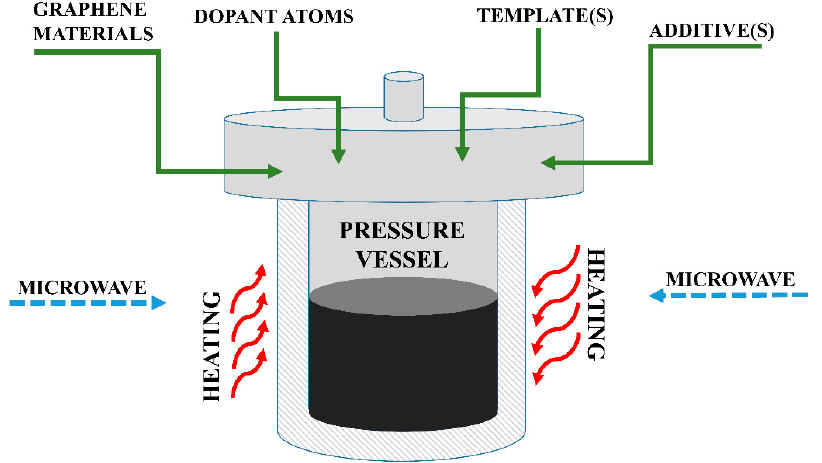
Figure 3. Schematic of stainless-steel autoclave and Teflon pressure vessel used for hydro(solvo)thermal synthesis.